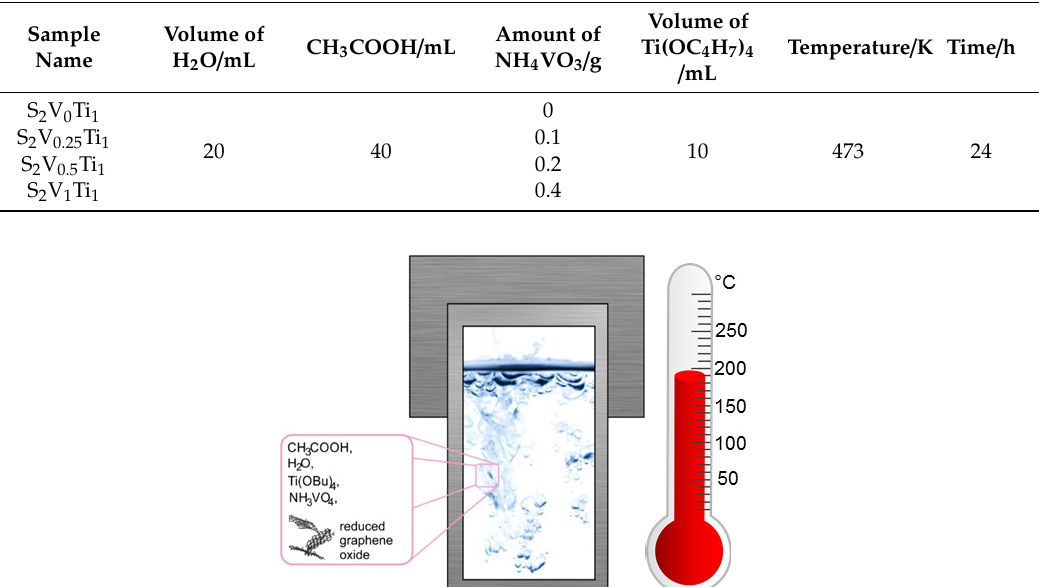
Table 1. Description of the reactants and conditions used for solvothermal synthesis of V x O y -TiO 2 -rGO composites.